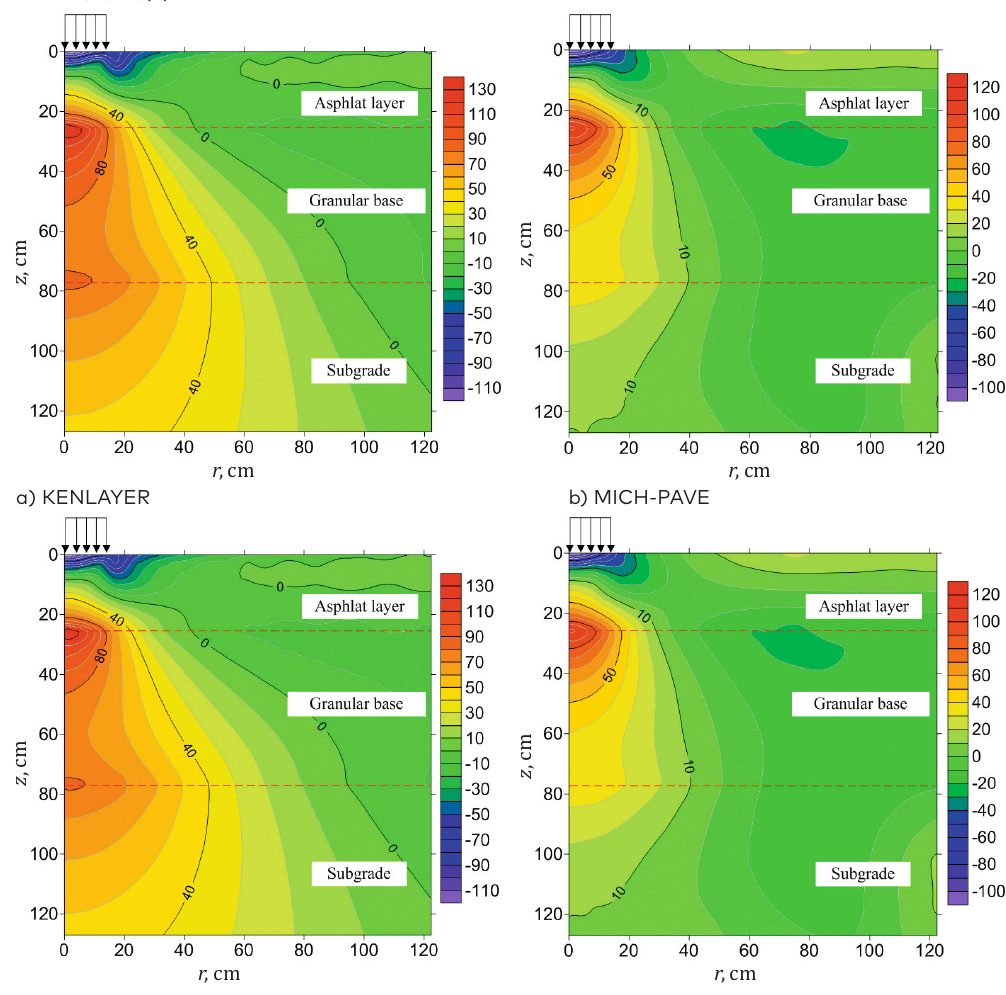
Figure 13. The contour map of the radial strain